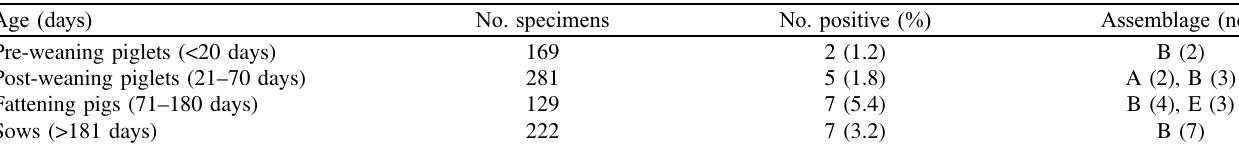
Table 3. The prevalence and assemblages of Giardia duodenalis in pigs of different ages in Xinjiang, China. Age